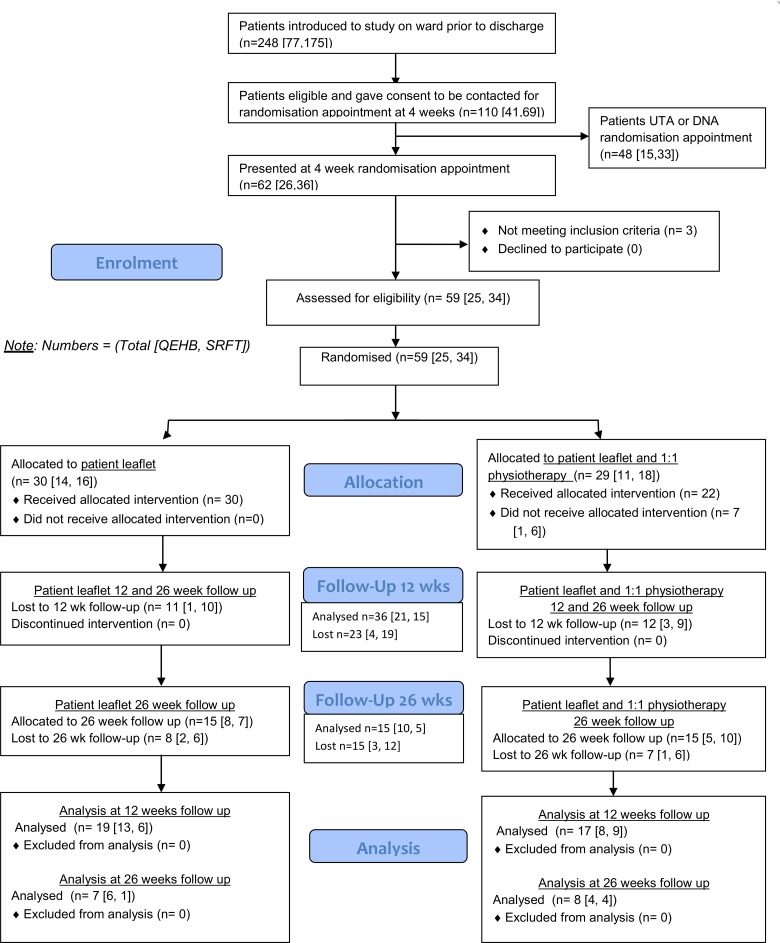
CONSORT diagram (period 14.01.13 to 12.6.14).